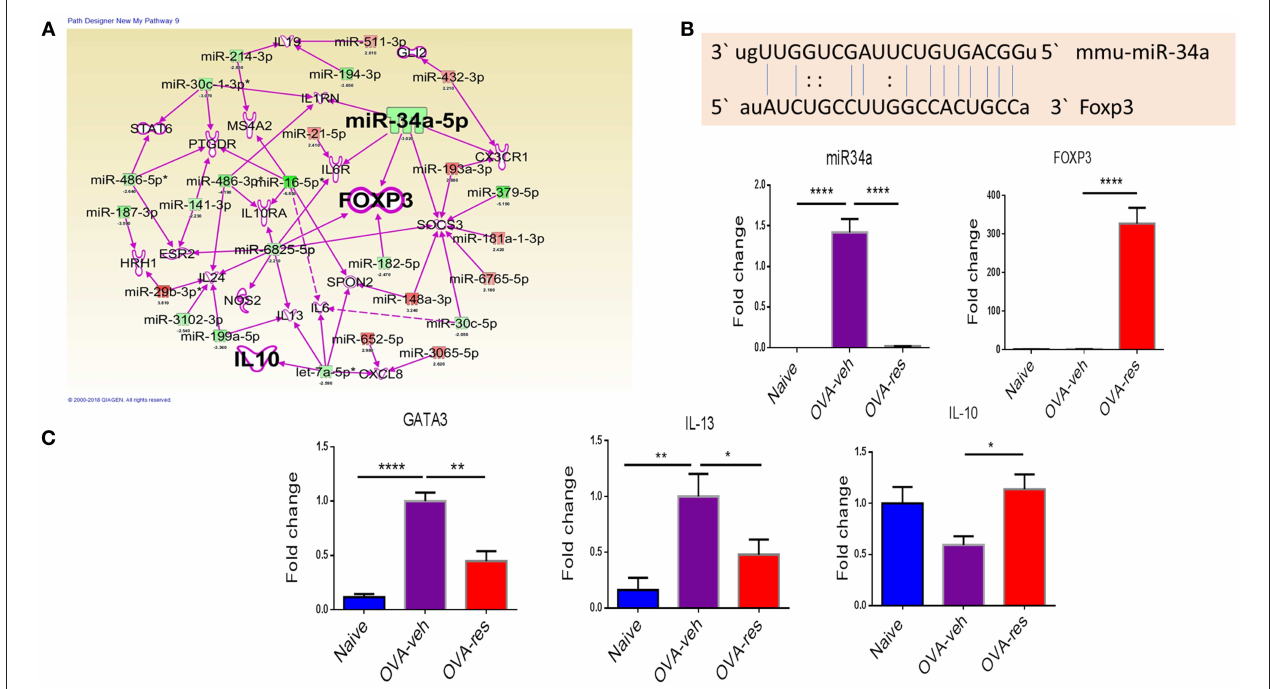
FIGURE 4 | Analysis of dysregulated miRNAs and regulation of Foxp3 and cytokine genes post resveratrol treatment. (A) Ingenuity Pathway analysis was performed to analyze dysregulated miRNAs and identify target molecules. (B) Shows the alignment of targeted gene and miR-34a using miRNA.org software. qPCR was performed to validate of the expression of miR-34a (C) and its target gene FOXP3 (D) , transcription factor GATA3 (E) , cytokine IL-13 (F) , and cytokine IL-10 (G) . The number of mice used (Naïve: n = 5, OVA-veh: n = 5, and OVA-res: n = 5). Data are shown as Mean + /– SEM of triplicates and asterisks (*) represent significance (* p < 0.05, ** p < 0.01). Significance of data was determined using ANOVA test and post-hoc Tukeys test. Each experiment was repeated at least three times.